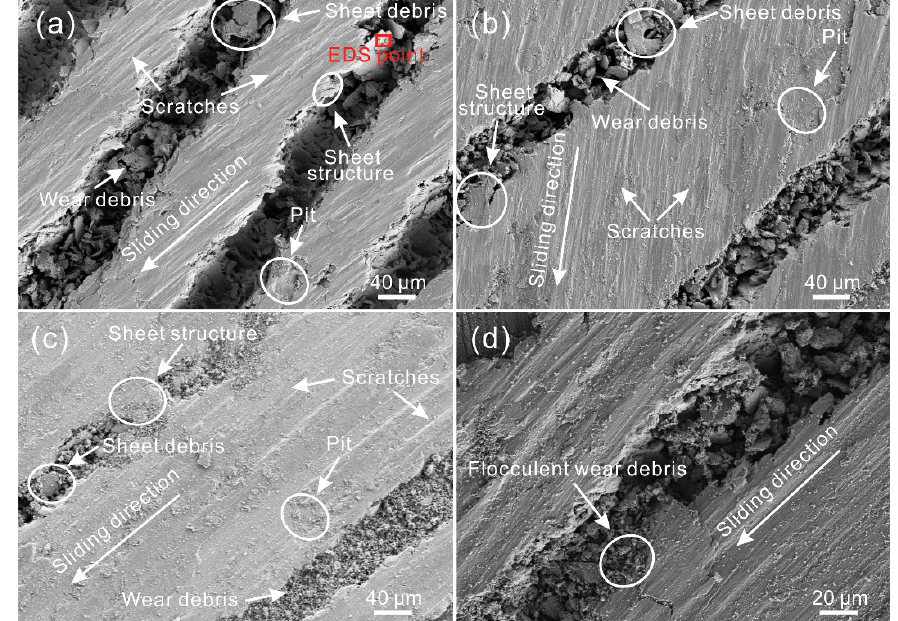
Figure 8. SEM images of the worn surface of the LGS with texture spacing of ( a ) 150 µ m, ( b ) 250 µ m (load of 0.3 N, sliding speed of 100 mm/s, frictional pair of GCr15 bearing steel); ( c ) SEM image of the worn surface of the LGS with texture spacing of 250 µ m (sliding speed of 400 mm/s); ( d ) SEM image of black wear debris on the worn surface of the LGS with texture spacing of 350 µ m (sliding speed of 400 mm/s). Table 4. Composition content of the worn surface and wear debris in the groove measured by point EDS (texturing spacing of 150 µ m, load of 0.3 N, sliding speed of 100 mm/s, frictional pair of GCr15 bearing steel).